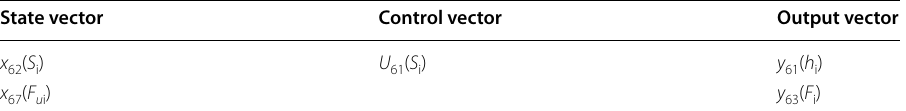
Table 2 Stand#6 state, control, and output vectors State vector Control